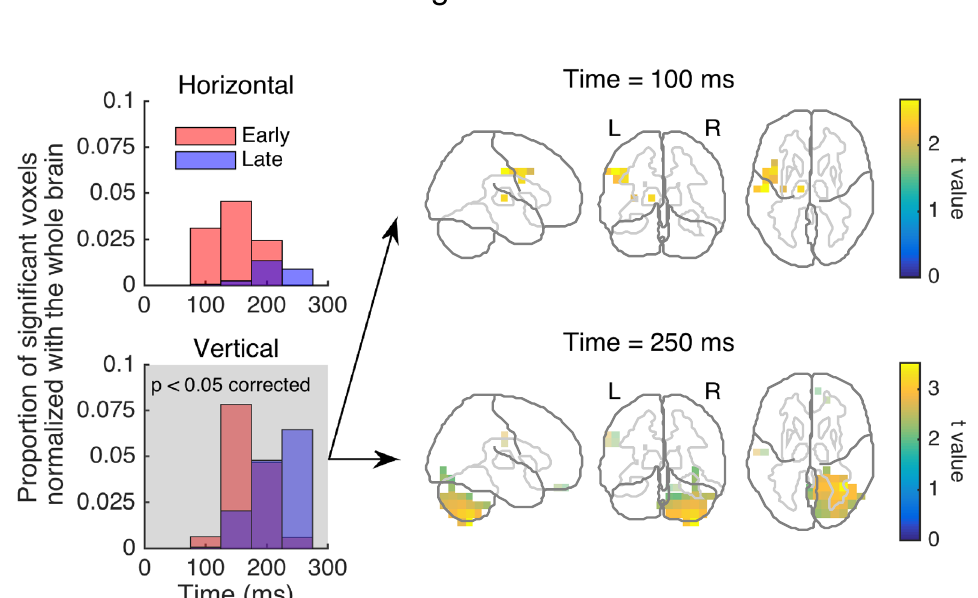
Figure 5. Oscillatory activities related to the execution of disparity-induced vergence. ( a ) Linear disparity model explains the 4-Hz coherence in the right middle temporal and cerebellar areas for the horizontal condition. ( b ) Stimulus-vergence interaction model explains the 4-Hz coherence in the left postcentral and right cerebellar areas for the vertical condition. Each panel in the left column shows the two subclusters of the voxels revealed by each model applied to the horizontal or vertical condition. Shaded panels show the significant clusters ( p < 0.05, corrected). Right panels show snapshots of the significant clusters revealed by each model. The most significant voxels are mapped onto three planes. Light-colored voxels represent the other subcluster (i.e., the late-peak subcluster in the top-right panel and vice